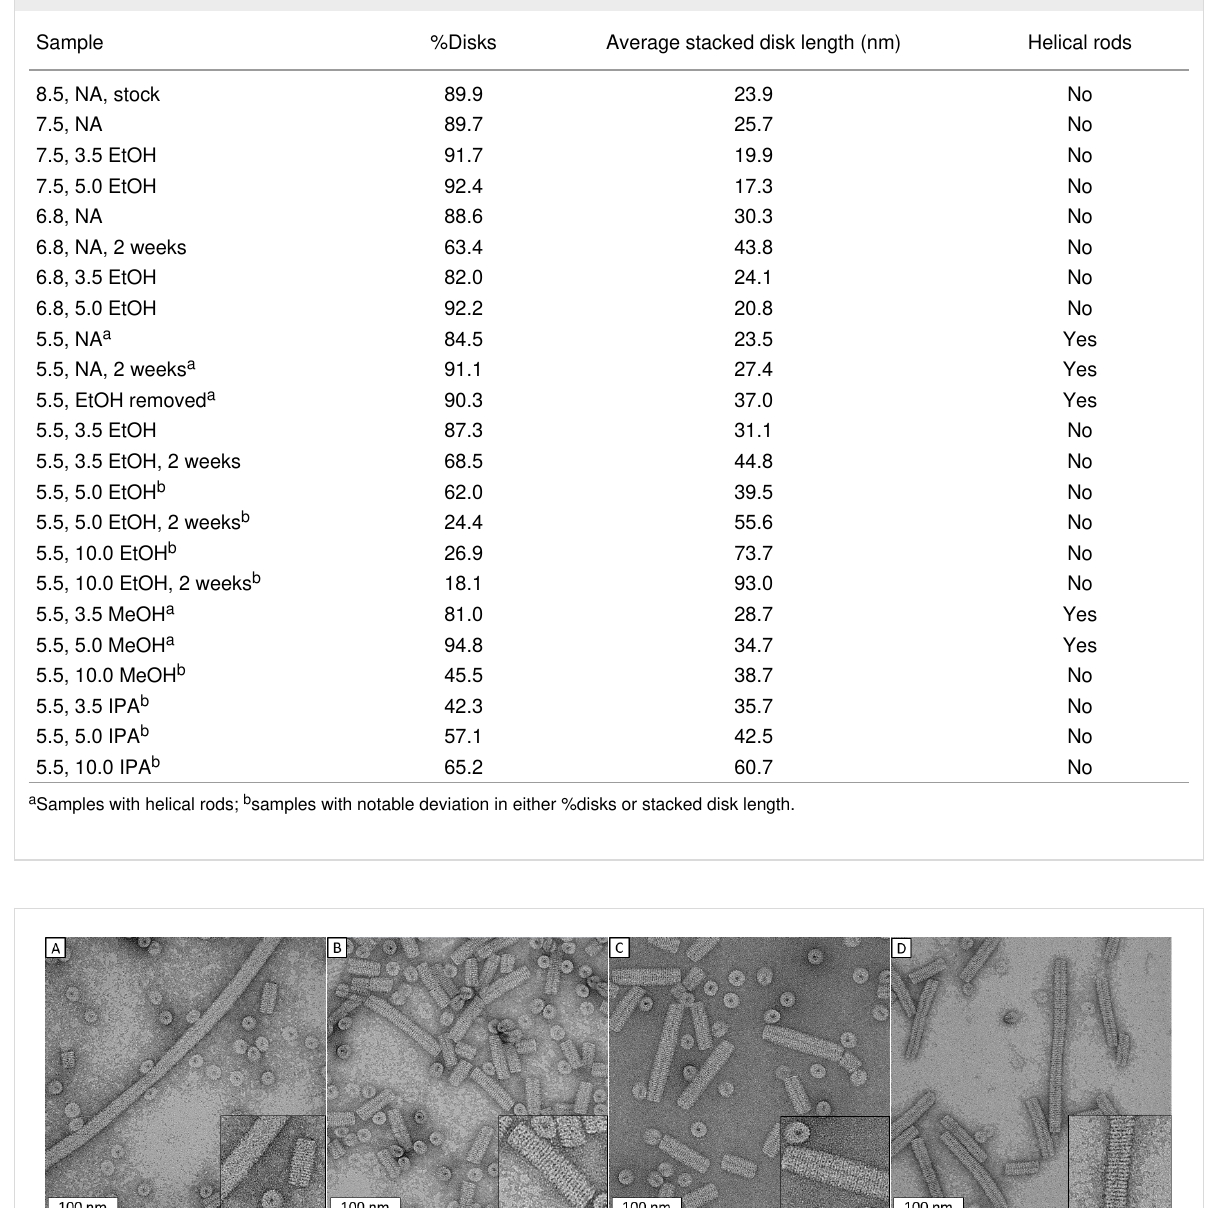
Table 1: Particle analysis from TEM images. Samples named as “pH, additive (mol %), notes”. NA is no additive. %Disks is the percent of individual disks out of all TMV-cp disks and stacked disks observed. For each sample, at least 1000 particles were analyzed from a single grid. A full statistical evaluation is not possible because only one grid was analyzed per sample. Instead, these results are intended to show trends in particle populations dependent on solution conditions and alcohol content.